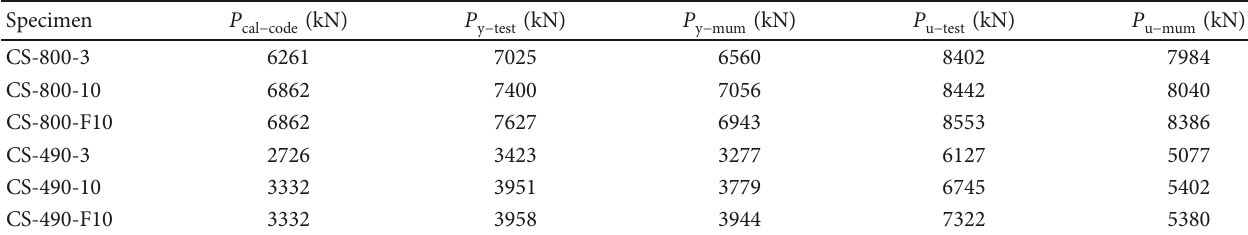
Table 6: Comparison between analysis results and test results for CFT specimens.